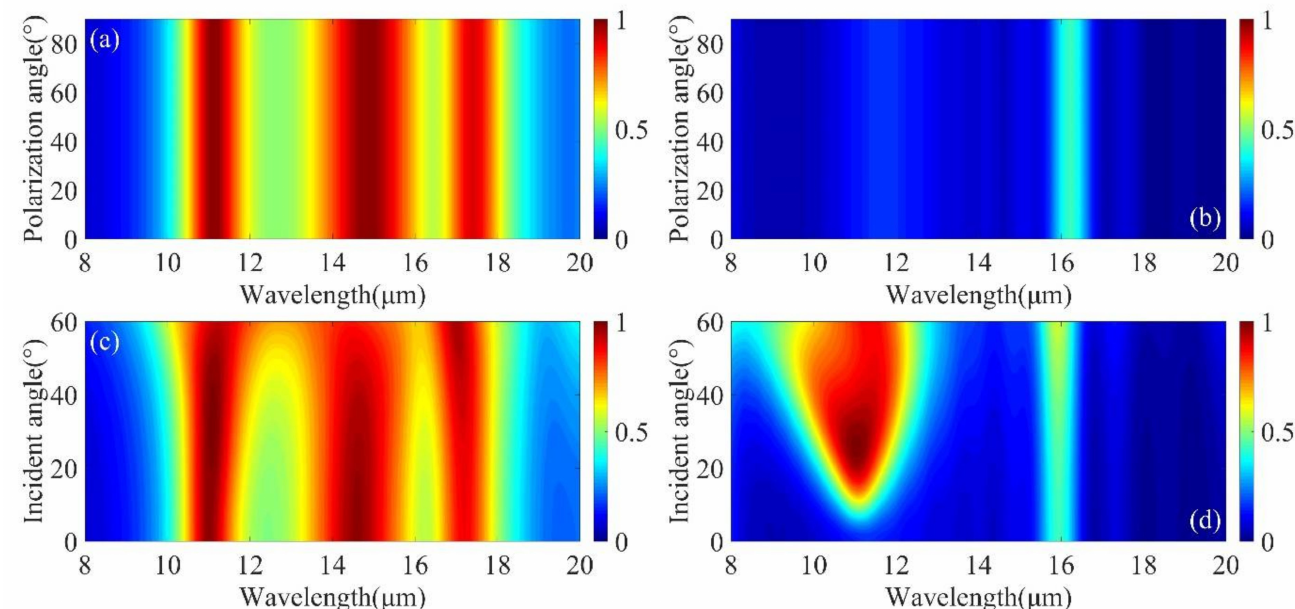
Figure 7. ( a , b ) Spectral response of nanodisk arrays with crystalline and amorphous phases at different polarization angles (0–90 ◦ ). ( c , d ) Simulated absorption spectra of Mo arrays with crystalline and amorphous phases at different (0–60 ◦ ) incidence angles, respectively. Other geometric parameters are fixed and are the same as used in Figure 2.